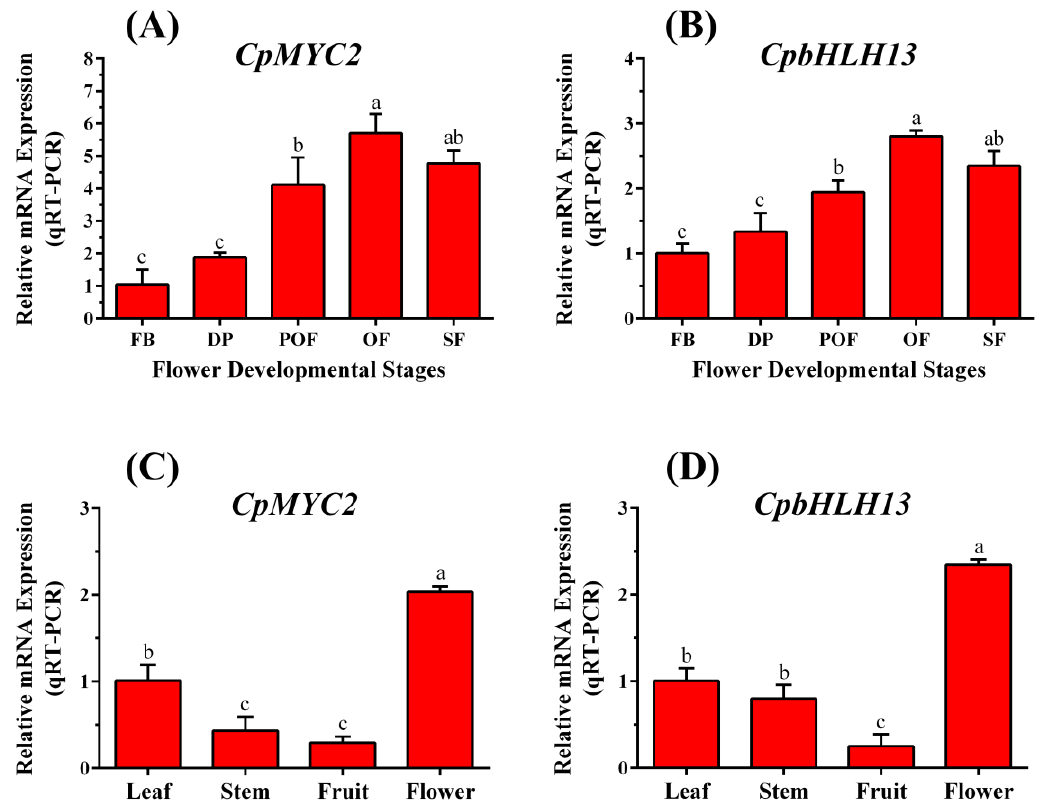
Figure 4. The transcriptomic expression pattern of ( A ) CpMYC2 and ( B ) CpbHLH13 during flower developing stages of H29. The stages are FB: flower bud, DP: display petal, POF: partially-open flower, OF: open flower, SF: senescing flower. Tissue-specific analysis of ( C ) CpMYC2 and ( D ) CpbHLH13 expression in wintersweet. The different letters on the bars show significance between the treatments by using least significant difference (LSD) at p < 0.05.